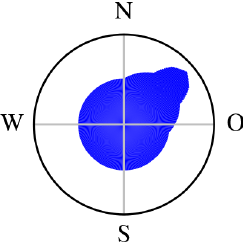
Figure 18. The wind rose used for the Borssele IV cases.